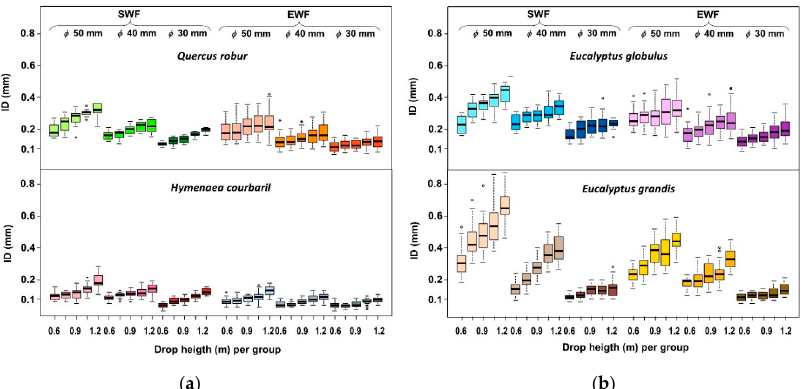
Figure 4. Box plot graphics: indentation depth (ID) for each wood specie. Different flooring types (solid wood flooring (SWF) and engineered wood flooring (EWF)), drop heights (0.60–0.75–0.90–1.05–1.20 m) and diameter balls (30–40–50mm) were represented. ( a ) traditional hardwood species applied on wood flooring; ( b ) fast-growing